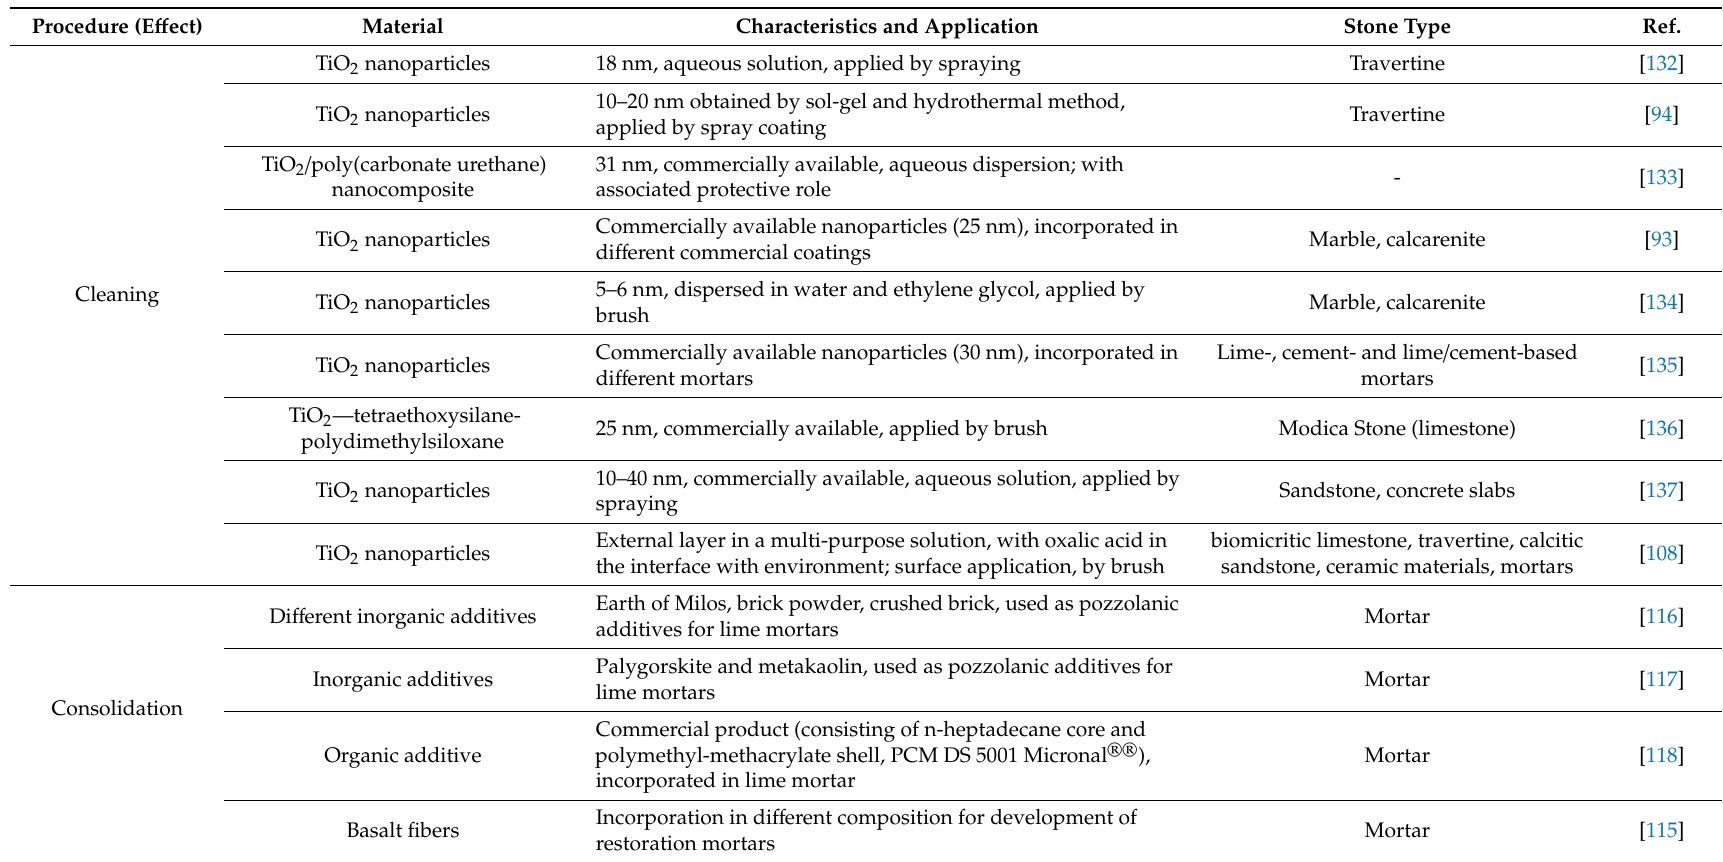
Table 5. Materials for the treatment of stones used in the vernacular constructions (references presented in chronological